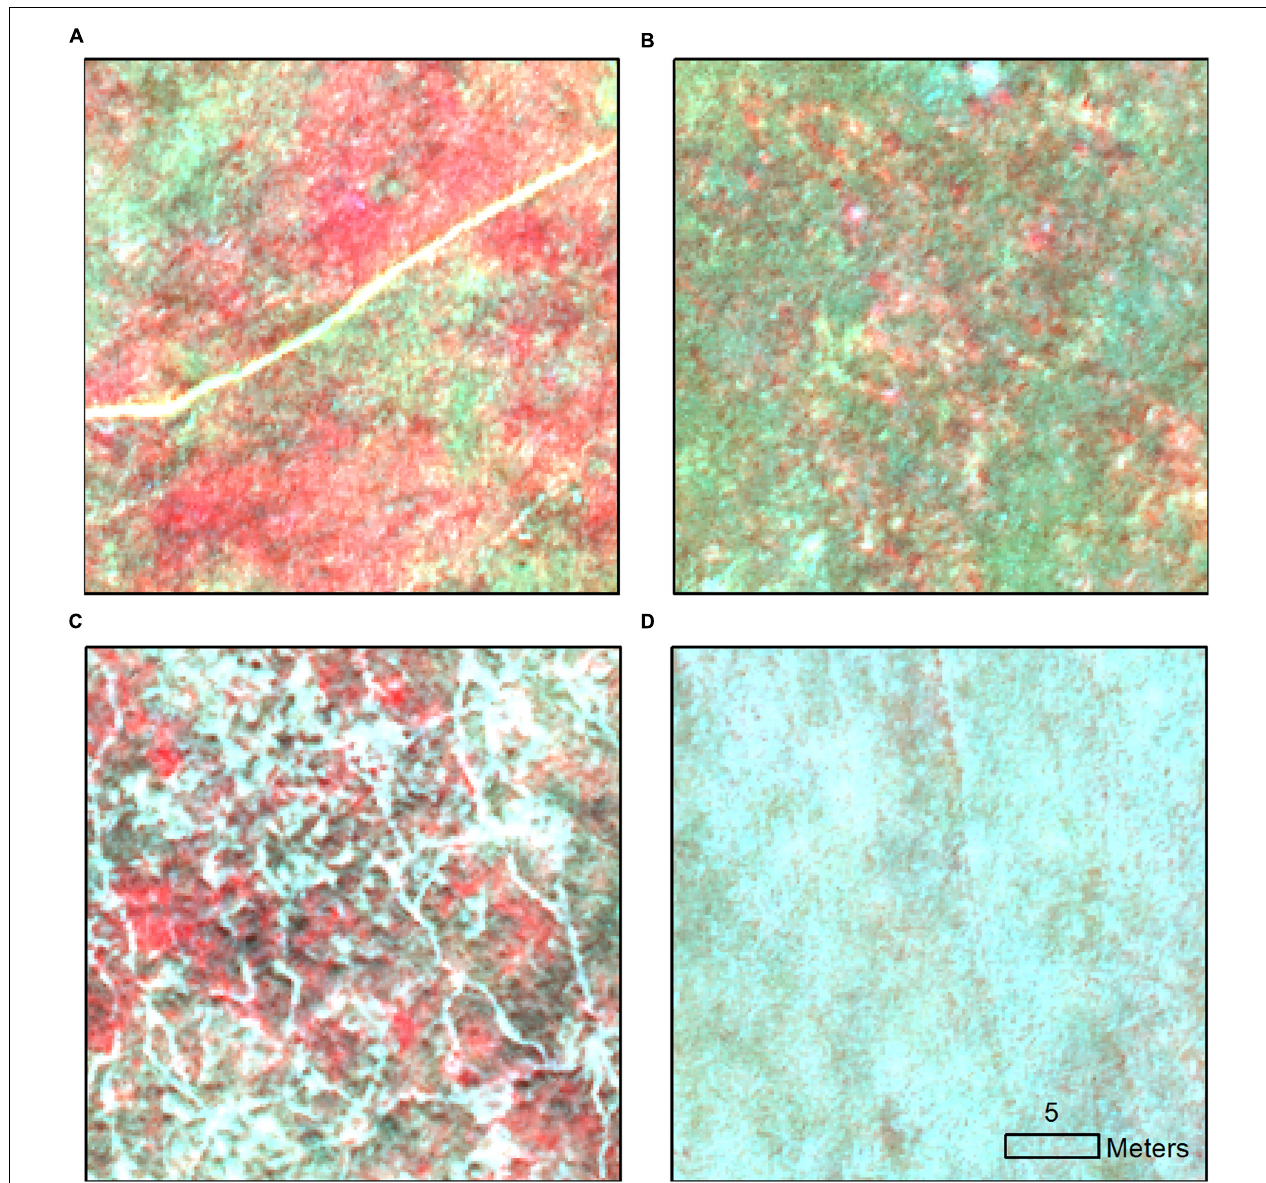
FIGURE 2 | Examples of characteristic local spectral patterns shown in the near-infrared image composite for (A) medusahead and clover-brome; (B) canarygrass within senescent grasses; (C) vetch within clover-brome and Italian rye grass matrix and (D) medusahead within taller senescent wild